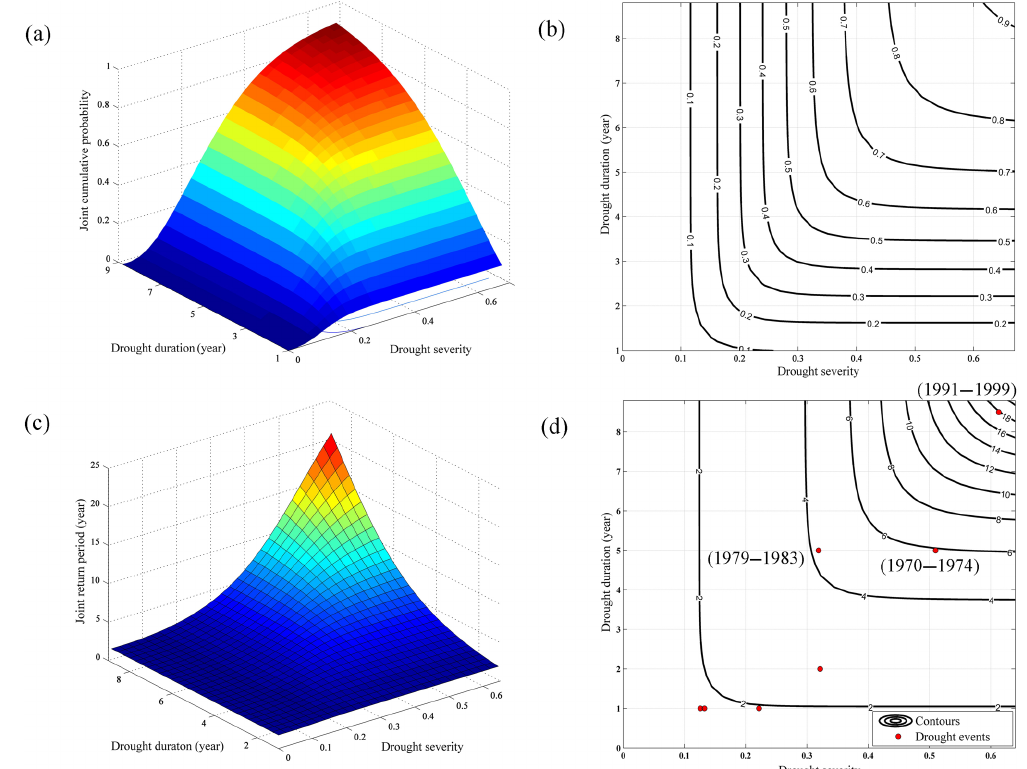
Figure 4. The joint probability distribution of drought duration and drought severity and the joint return period: (a) and (b) are the three- dimensional and contour maps of the joint probability density function of the Frank copula, respectively; (c) and (d) are the three-dimensional and contour maps of the joint return period of drought duration and drought severity,